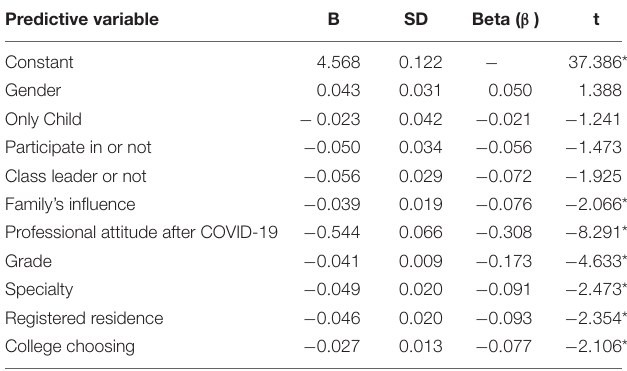
TABLE 10 | Multi influence factor analysis of medical students’ professional identity after